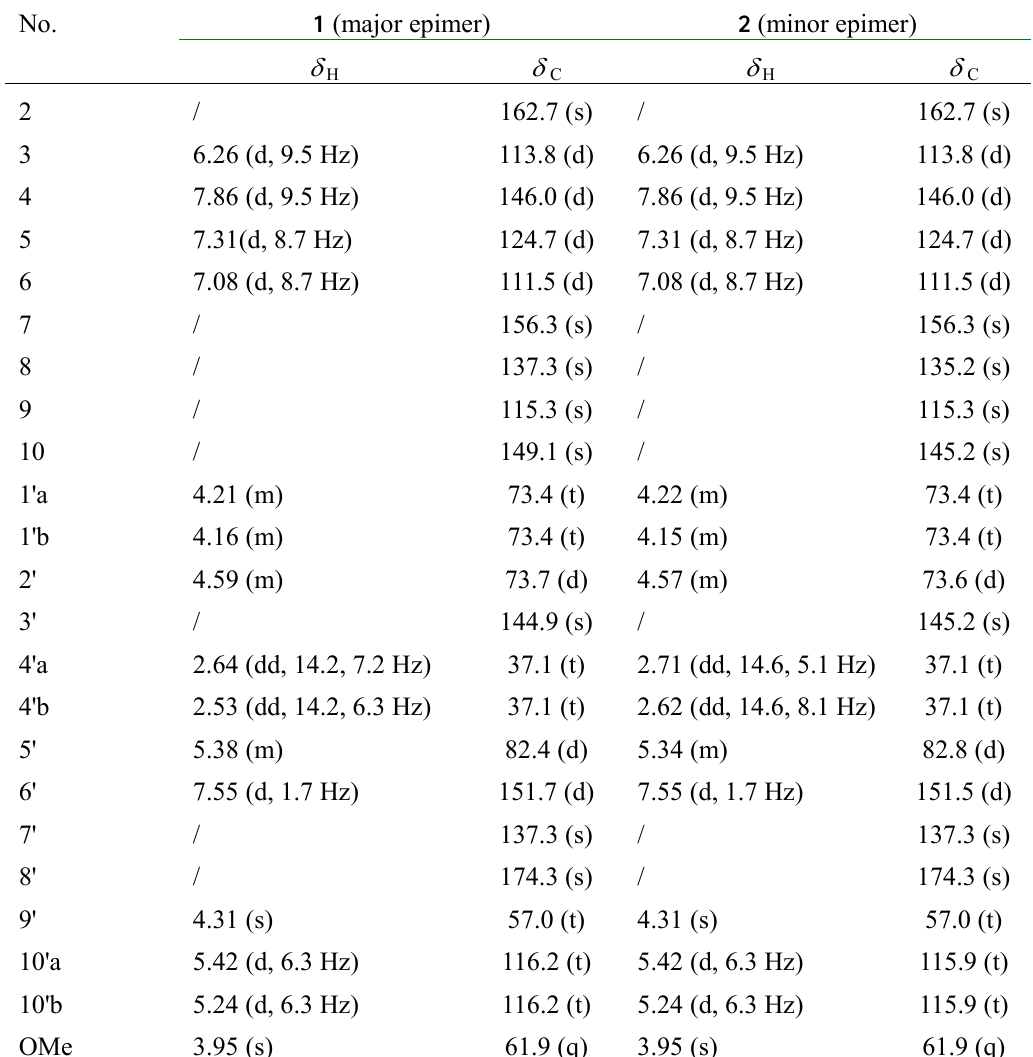
Table 1. The 1 H- and 13 C-NMR data for compounds 1 and 2 (in CD